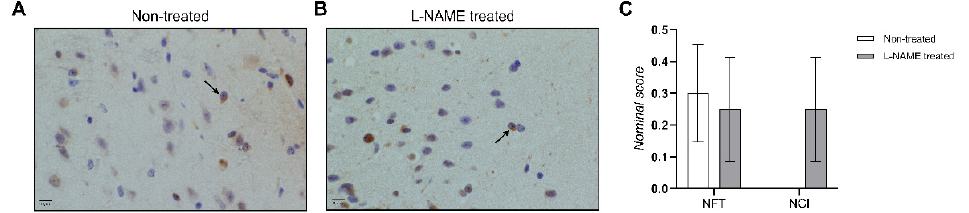
Figure 4. Histopathological analysis of pTAU stained cerebral tissue of one hemisphere of non-treated and 16-weeks L-NAME-treated mice. Representative images of ( A ) non-treated and ( B ) L- NAME-treated of hippocampal cortex tissue, respectively. There were sparse neuronal intracytoplasmic inclusions (NCI) (black arrows), which were considered pretangles or NCI. In none of the cases was there a fulminant neurofibrillary tangle pathology. ( C ) Neuropathological scoring of hippocampal and cortical tissue of one hemisphere of 16-week control and L-NAME-treated animals. NFT = neurofibrillary tangles, and NCI = neuronal intracytoplasmic inclusions. Data are presented as mean ± SEM. Scale bar = 10 µm.